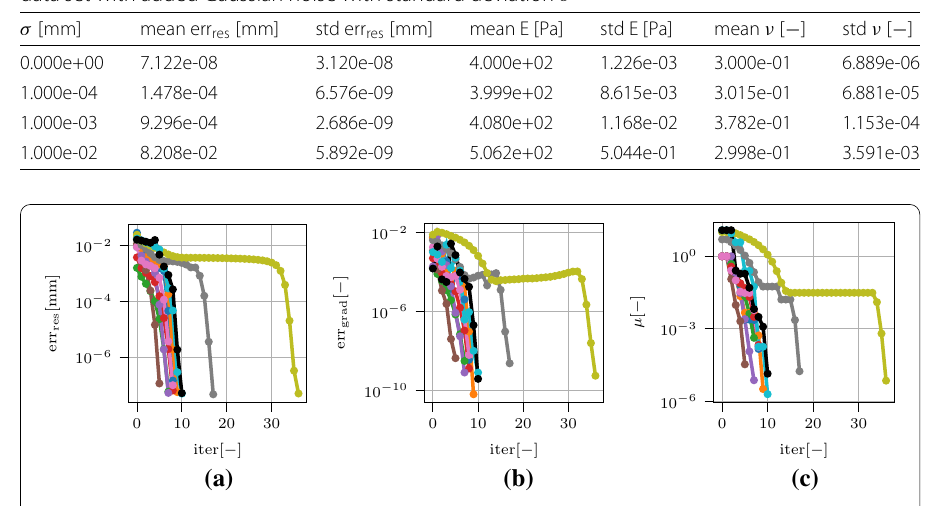
Table 2 Mean values and standard deviations (std) over all runs with different initial guesses per data set with added Gaussian noise with standard deviation σ